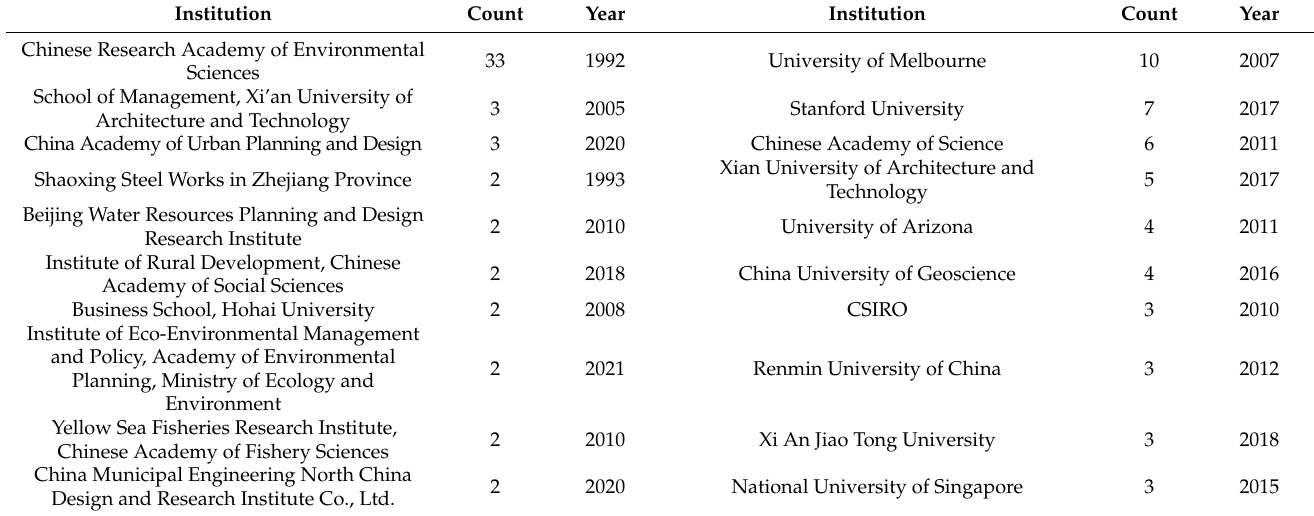
Table 3. Comparison of number of publications by research institutions (top